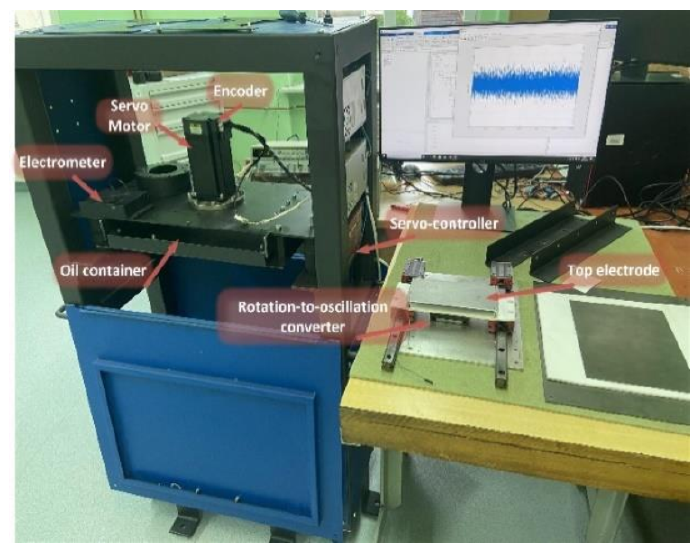
Figure 5. Photo of the